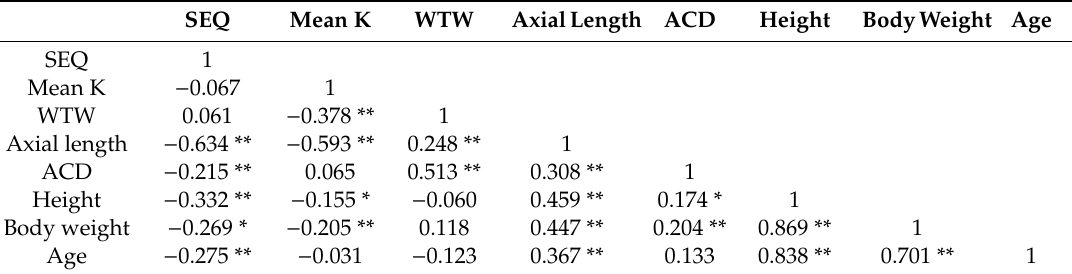
Table 5. Correlation analysis among various variables in Korean school children ( n =